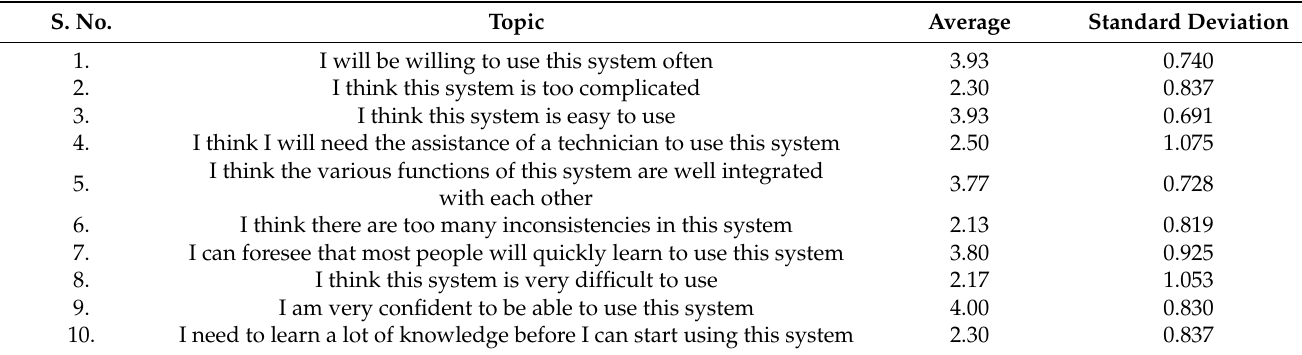
Table 1. SUS questionnaire analysis